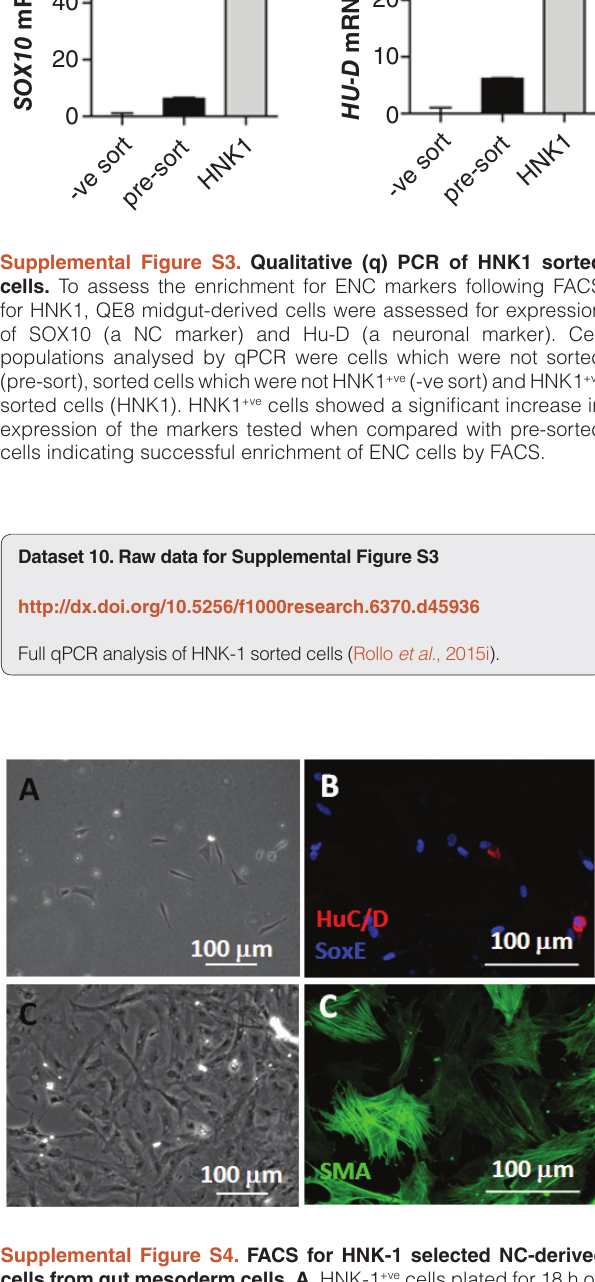
Supplemental Figure S4. FACS for HNK-1 selected NC-derived cells from gut mesoderm cells. A . HNK-1 +ve cells plated for 18 h on laminin (phase contrast). B . HNK-1 +ve cells at 66 h in vitro showed NC markers: HuC/D (neurons) and SoxE (ENC cells). C . HNK-1 –ve cells plated for 66 h had flat fibroblastic morphology (phase contrast). D . Nearly all HNK-1 –ve cells plated for 66 h were highly flattened and exhibited smooth muscle actin (SMA) labelling.